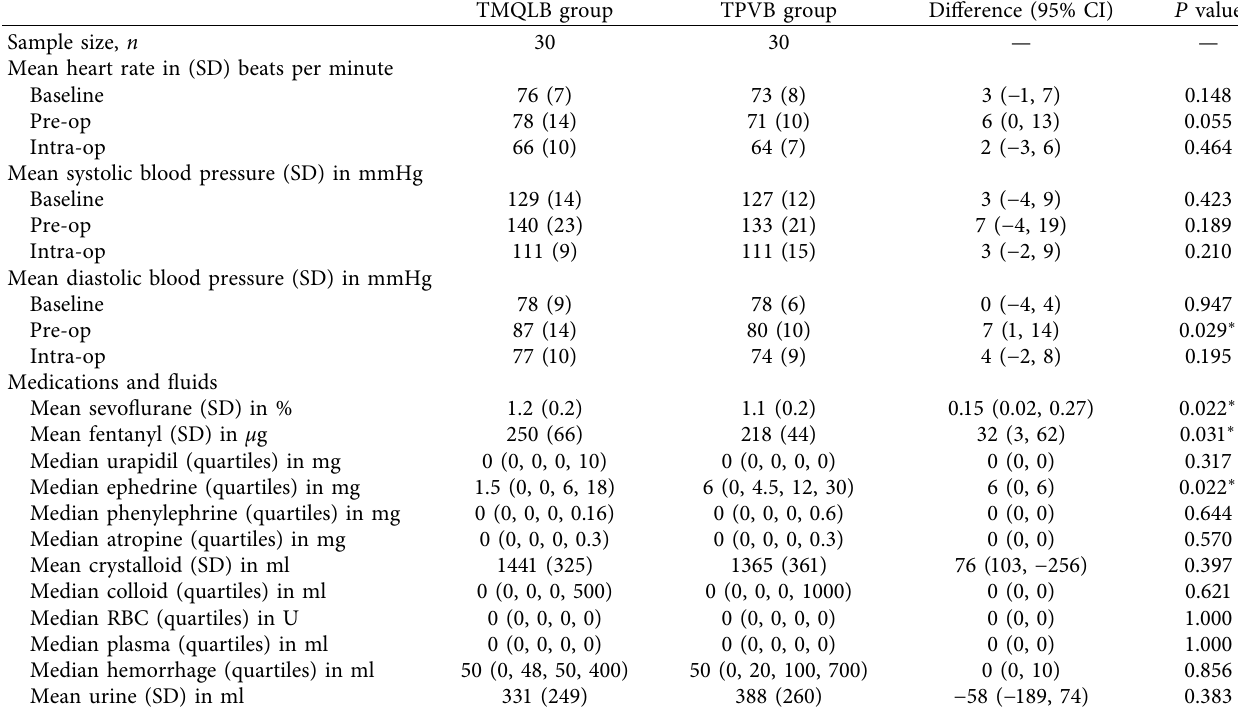
Table 3: Intraoperative hemodynamic changes and medication used in transmuscular quadratus lumborum block and paravertebral block groups.